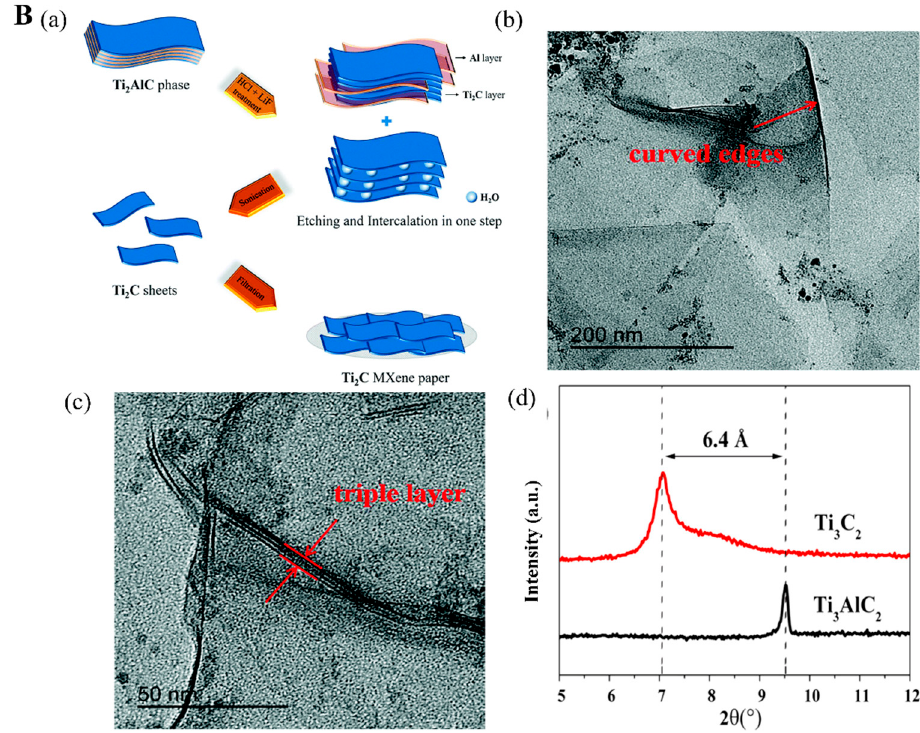
Figure 2. ( A ). ( a ) Schematic of Ti 3 C 2 T x MXene synthesis via HF-etching. The SEM images for ( b ) Ti 3 AlC 2 MAX phase, ( c ) multilayer Ti 3 C 2 T x MXene, ( d ) delaminated Ti 3 C 2 T x MXene nanosheets. Reproduced with permission from Refs. [24,28]. ( B ). ( a ) Ti 2 C MXene synthesis process. ( b , c ) TEM for exfoliated Ti 2 C MXene nanosheets. Reproduced with permission from Ref. [30]. ( d ) X-ray diffraction spectra for Ti 3 C 2 MXene its MAX phase precursor. Reproduced with permission from Ref. [31] .